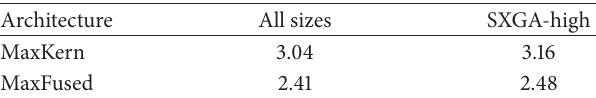
Table 7: Normalized Kernel-Ratios (geometric mean of all kernel speedups, normalized with regard to compute resources and band- widths) relative to